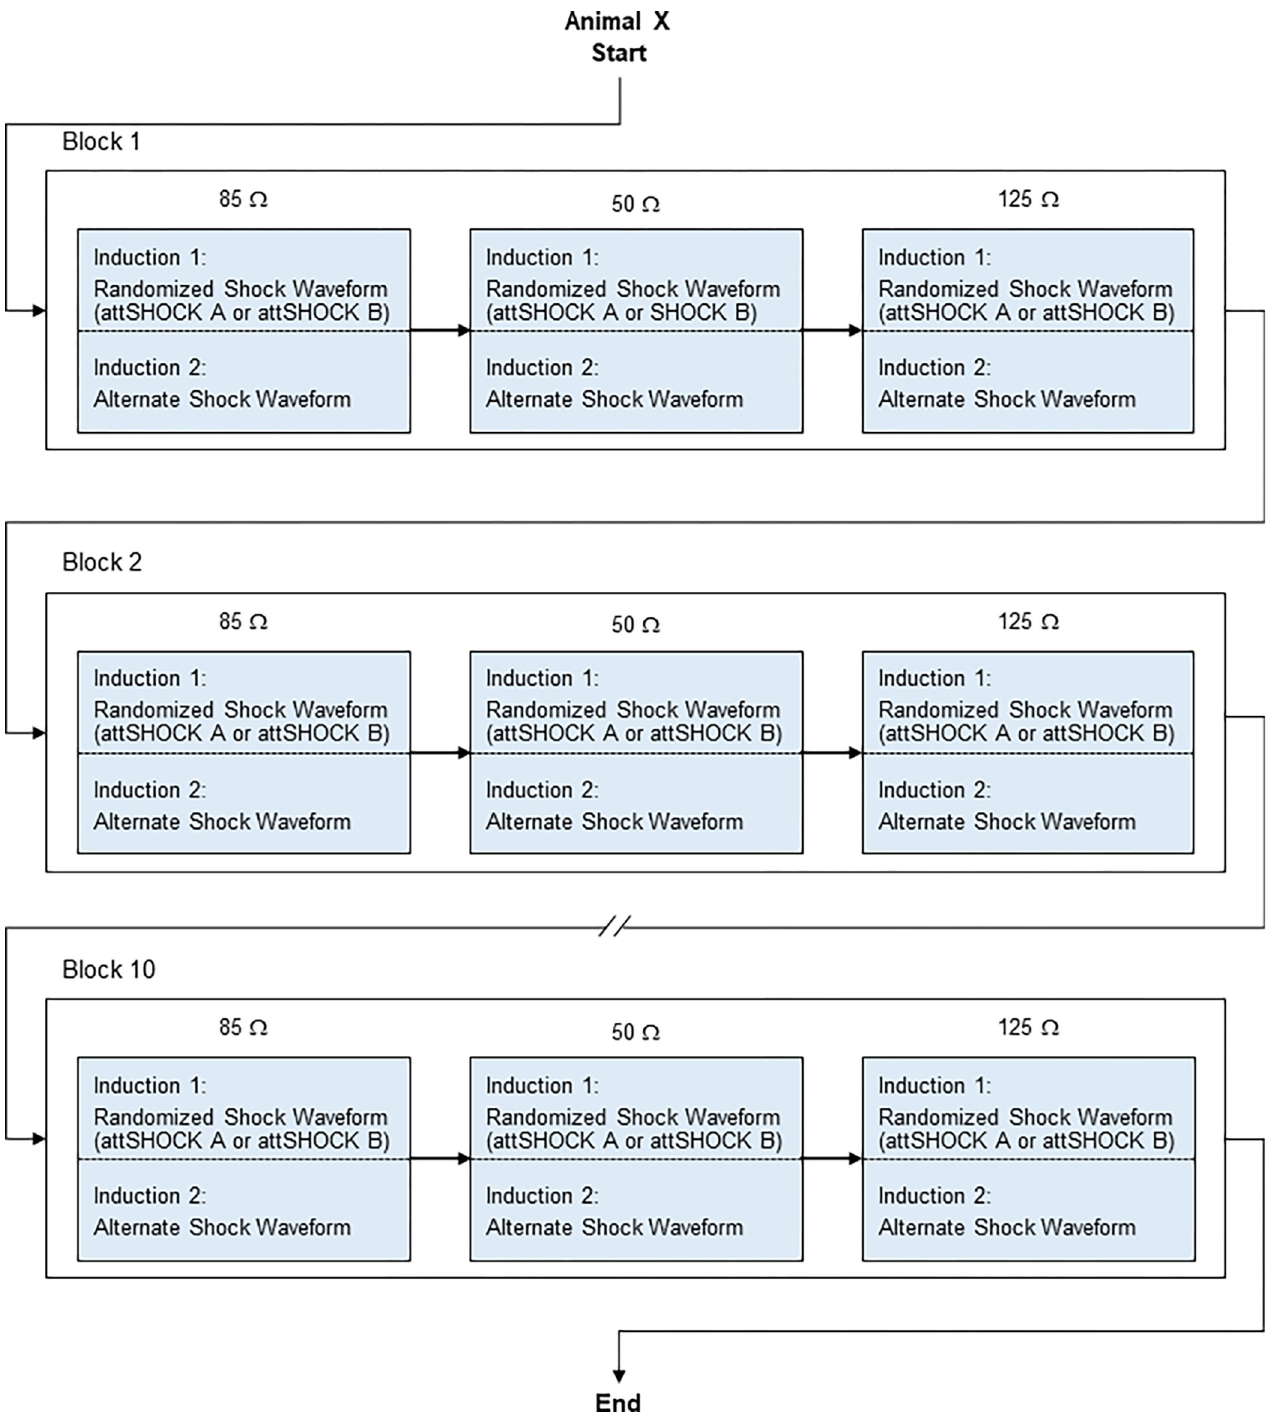
Fig 7. Animal Study #2 shock sequence. Figure illustrating attSHOCK A and attSHOCK B defibrillation shock sequence for each animal. att = attenuated.